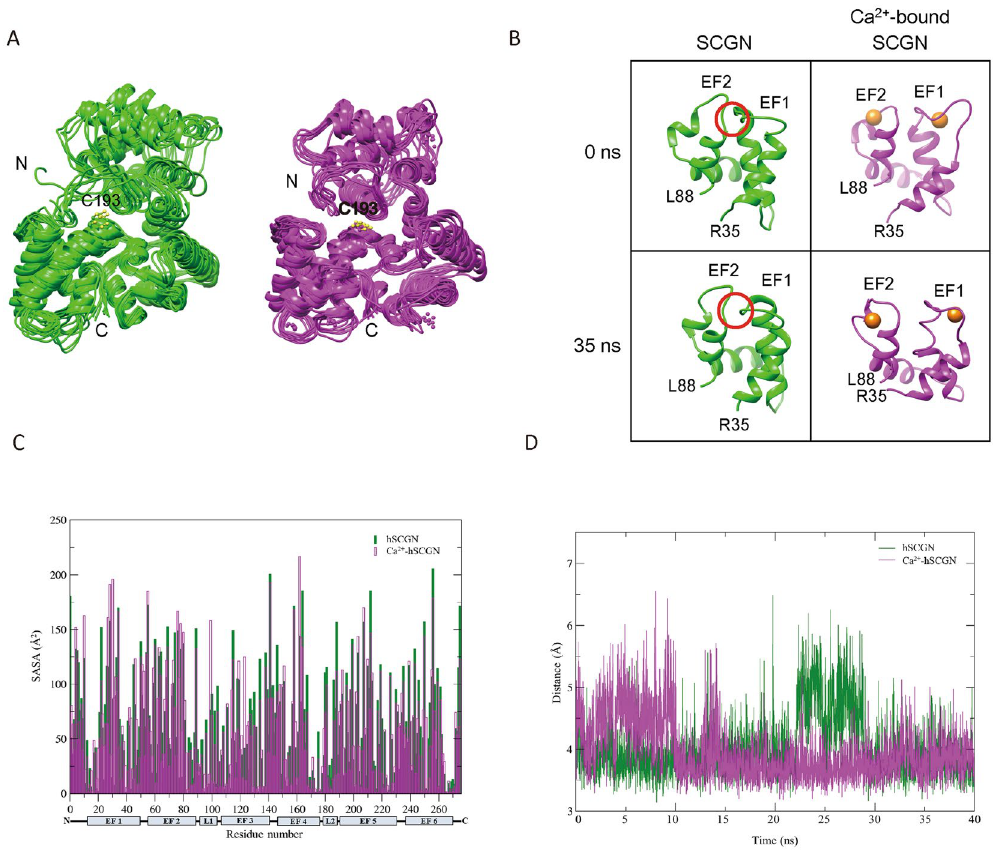
Figure 3. Dynamics of apo and six Ca 2 + -bound hSCGN in molecular dynamics simulation. ( A ) The coordinates of apo-hSCGN and Ca 2 + -bound hSCGN saved every 5 ns during MD simulations are superimposed, respectively. ( B ) Snapshots of the domain I of apo-hSCGN and Ca 2 + -bound hSCGN at 0 ns and 35 ns. Ca 2 + ions are drawn as orange spheres. The conformation of the red circled area is a β -sheet at 0 ns when analyzed by STRIDE (http://webclu.bio.wzw.tum.de/cgi-bin/stride/stridecgi.py). ( C ) The average SASA values for every residue of 400 structures saved every 100 ps during 40 ns simulation. ( D ) The distances between Cys253 and Cys269 during simulation for apo-hSCGN (green) and Ca 2 + -bound hSCGN